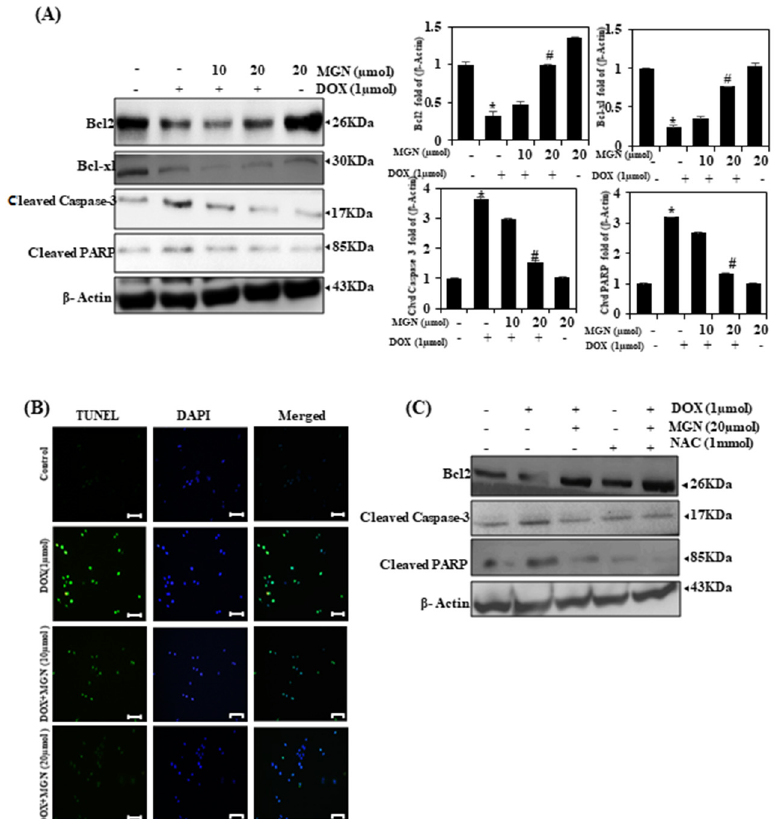
Figure 7. Pretreatment with MGN protects endothelium cells from DOX-induced apoptosis. For the study, control HUVECs and pretreated cells (10 or 20 µ M MGN for 24 h) and/or DOX. ( A ) Expression level was assessed with immune blotting for apoptotic regulatory proteins such as Bcl-2, Bcl-xL, caspase-3, and PARP. SDS–PAGE is used as a routine tool for protein purification, with β -actin as an internal control. ( B ) Transferase-mediated dUTP-fluorescein nick end labeling (TUNEL) is used to test for DNA fragmentation. Three cell samples with average numbers of apoptotic positive cells are seen under the microscope (200 × magnification). Densitometry was used to measure the difference in protein band intensities. The outcome was measured and expressed as a fold change compared to the control ( n = 3). ( C ) Cells were pretreated with NAC (2 mM) for 1 h, followed by treatment with MGN (20 µ M for 24 h) and/or DOX (1 µ M) to determine the level of Bcl2, cleaved caspase-3, and cleaved PARP. Data are represented as mean ± SEM. One-way ANOVA plus Tukey’s post hoc analysis analyzed the comparison between groups. * p < 0.05 reflects significant differences from the healthy control. # p < 0.05 reflects significant differences in contrast to DOX alone and MGN with DOX-treated